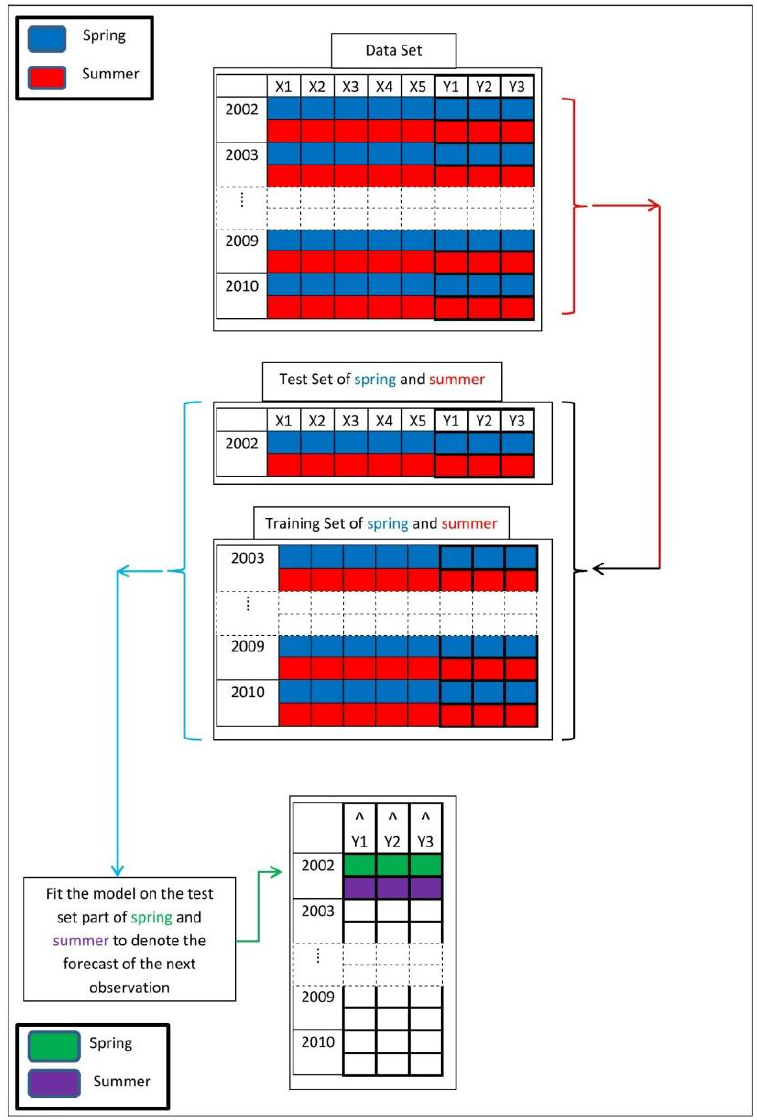
Figure 3. Cross validation procedure.